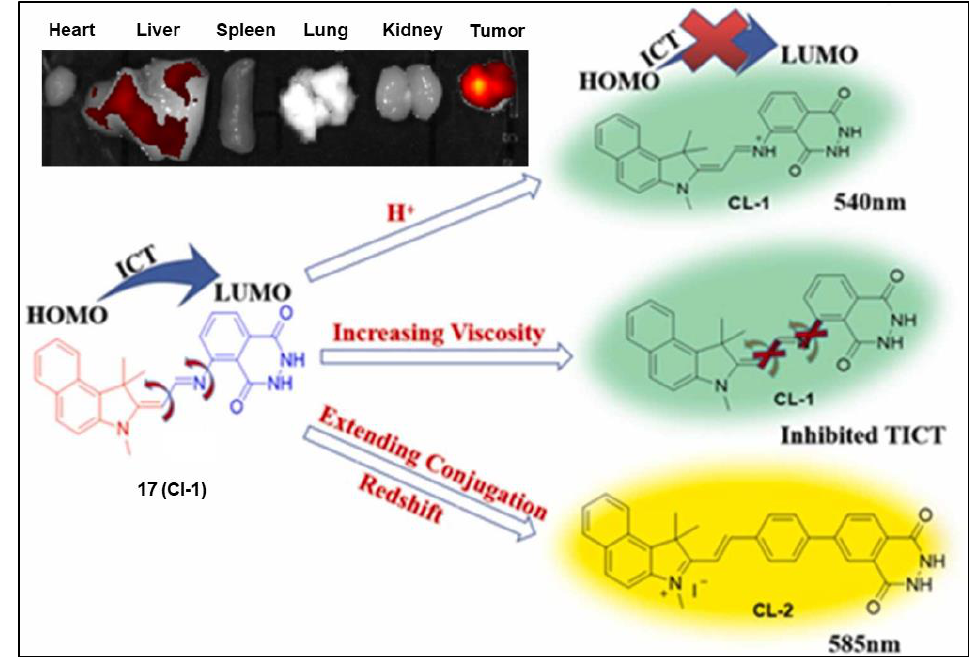
Figure 18. Design strategy of probe 17 . Fluorescence images of organs and tumors of tumor-bearing mice after tail vein administration of 17 (100 μM). Adapted with permission from [ 84]. Copyright (2023) Elsevier.